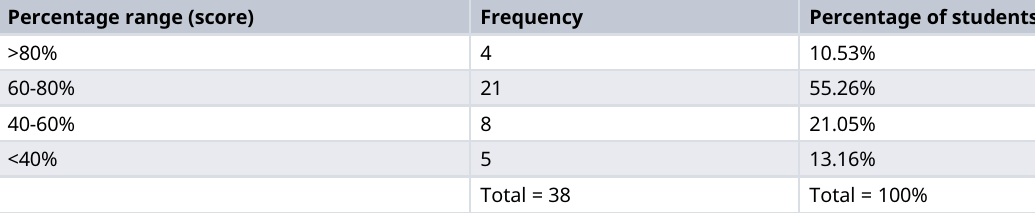
Table 3. Results of the students ’ score in non-routine surprise exam based on the MCQ questionnaires for students. Percentage range